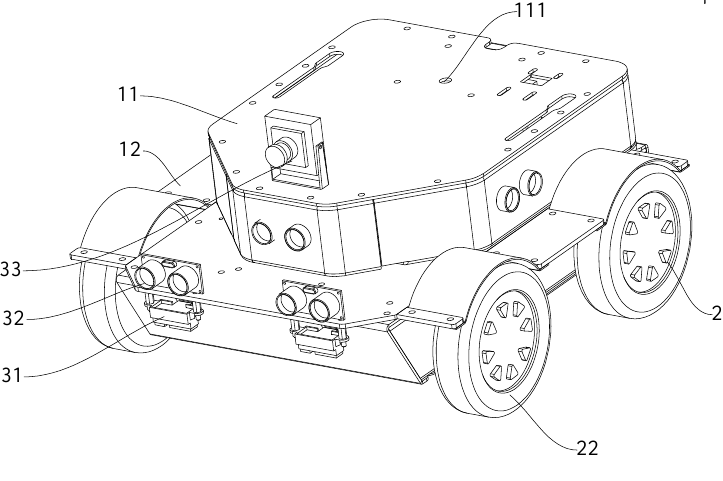
Figure 9. Physical prototype. Table 2. Notes to physical prototype.